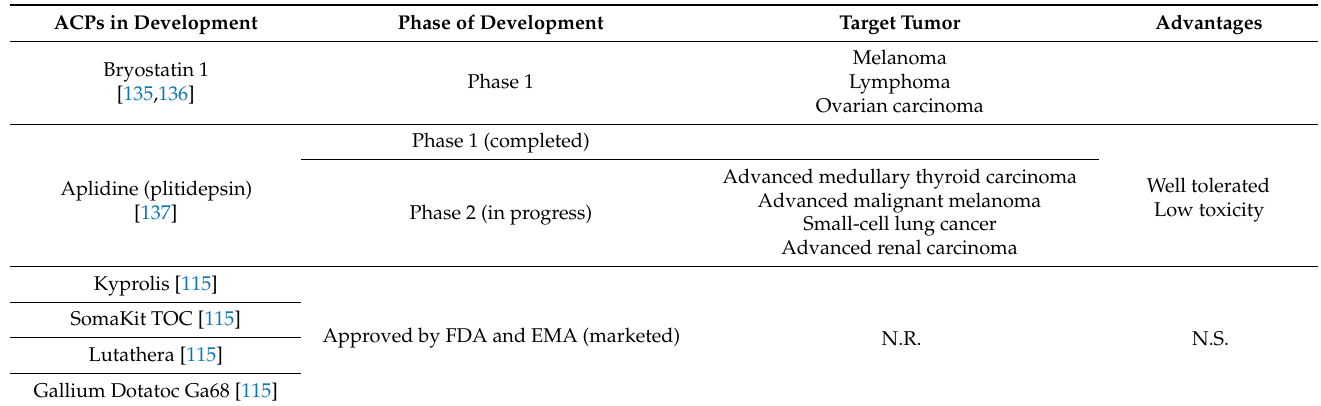
Table 2. ACPs in clinical trials ongoing or already approved and